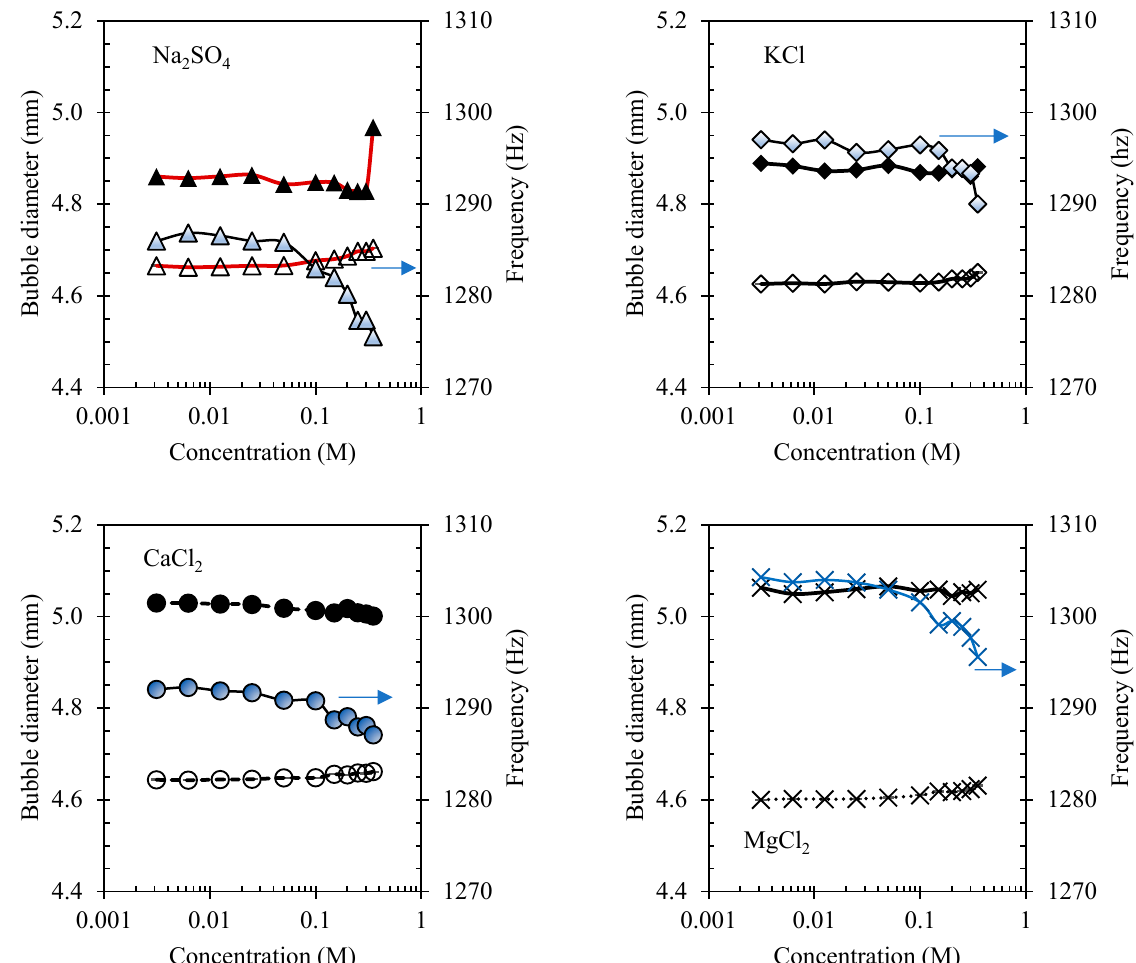
Figure A4. Acoustic frequency and bubble size in different salt solutions. The larger bubble size corresponds to those estimated from imaging.